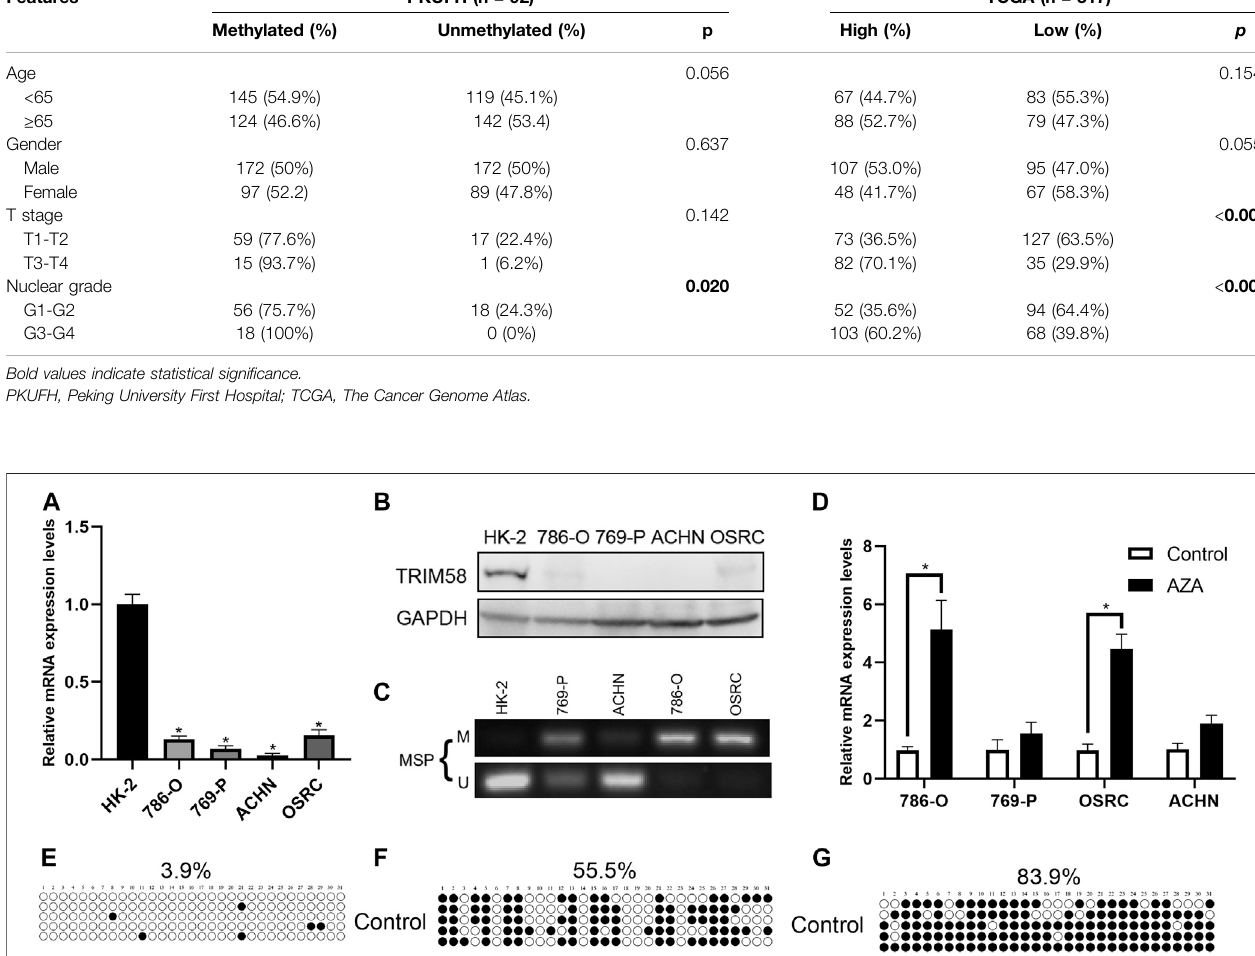
TABLE 1 | Association of TRIM58 promotor methylation with clinicopathological features in ccRCC. Features